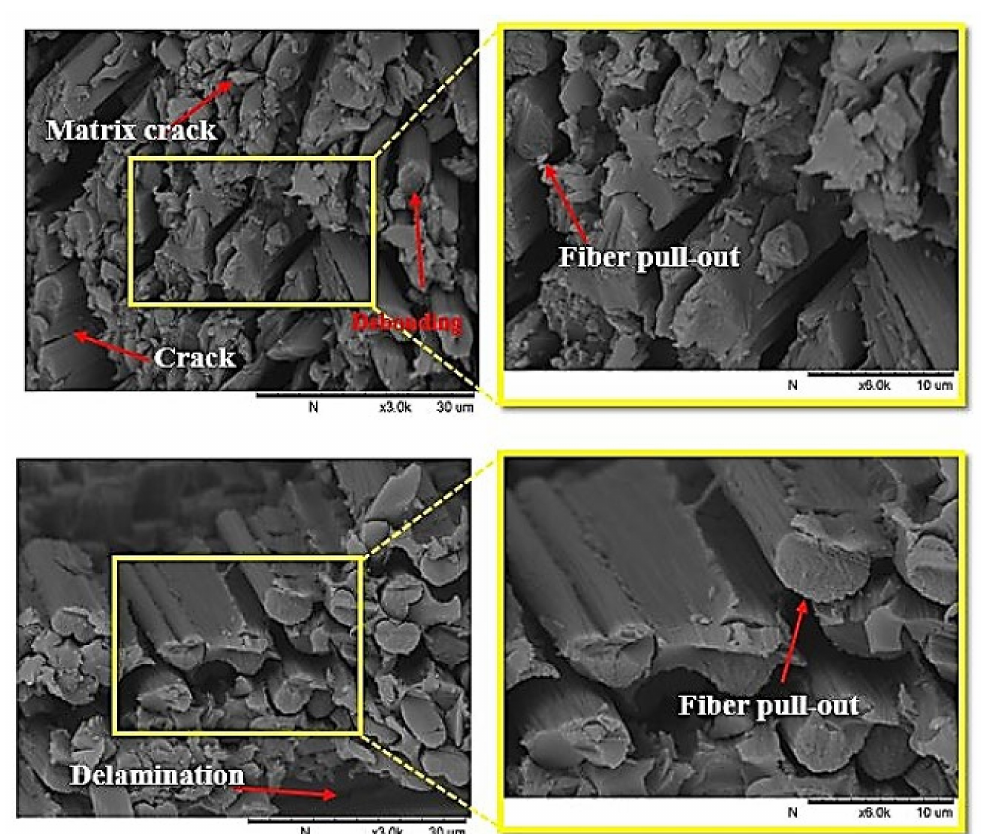
Figure 14. Low- and high-magnification SEM images of the cross-section of the fractured surfaces of the composite laminates at the face side after impact tests.